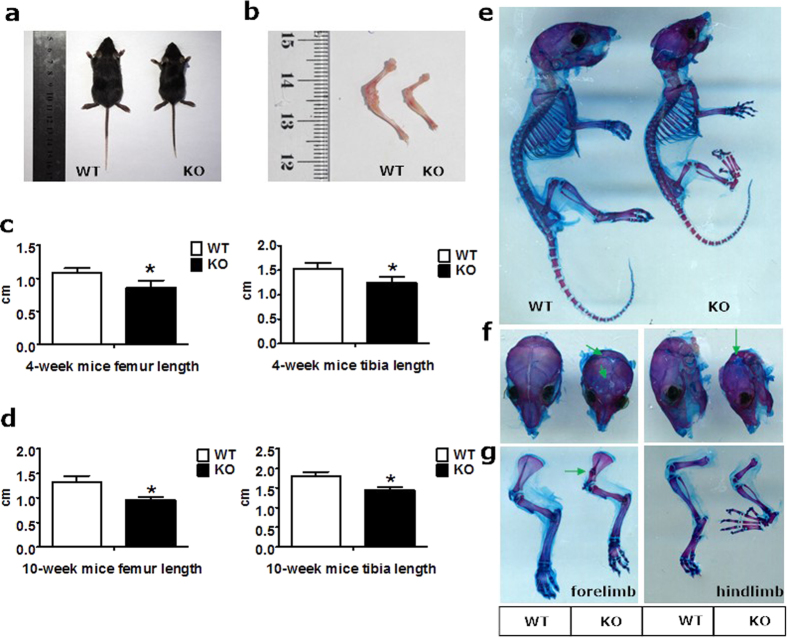
Conditional knockout PKD1 in vivo with Osx::PKD1fl/fl mice caused postnatal growth defects.(a) Photographic appearance of the 4-week-old WT and KO mice. KO mice were smaller than control mice at 4 weeks. (b) Picture of hind limbs from the 4-week-old WT and KO mice. (c,d) The length changes of femur and tibia from hind limb of 4-week-old and 10 weeks of WT or KO mice. Measurements were presented as mean ± SD (n ≥ 7). The data in each group was analyzed using unpaired, two-tailed Student’s t-test. The level of significance was set at *p < 0.05. (e) Whole-mount skeletal was stained by Alizarin red and Alcian blue staining of 14-day-old of WT or KO mice. (f) Alcian blue/Alizarin red staining of skulls from WT and KO mice (green arrows showed undeveloped skull). (g) Alcian blue/Alizarin red staining of lone bone from WT and KO mice. The arrow reviewed abnormal nodules in scapula.